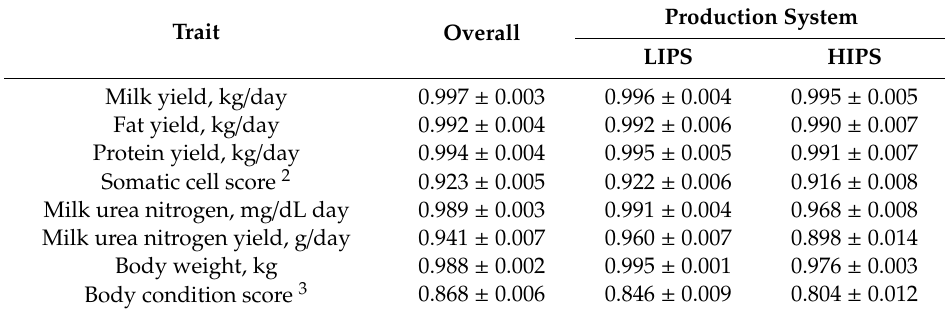
Table 3. Estimates of Pearson correlation coe ffi cients and standard error for actual and predicted 1 values of daily milk production traits, body weight, and body condition score in two contrasting pasture-based dairy production systems: a low-intensity production system (LIPS) and a high-intensity production system